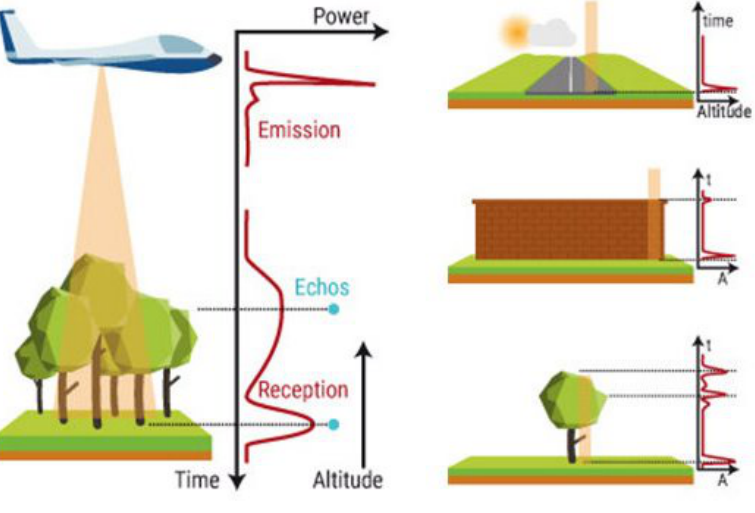
Figure 1. Schematic FWF signals from an airborne lidar, Copyright © YellowScan [3].